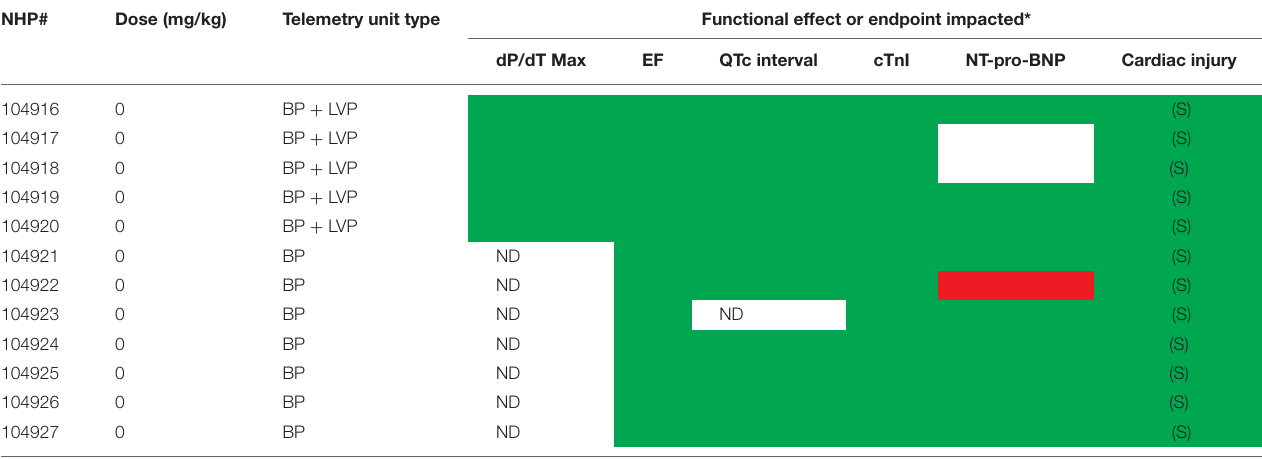
TABLE 4B | Relationship between contractile function, cardiac biomarkers, QTc interval and myocyte injury in NHP treated chronically with Vehicle. NHP# Dose (mg/kg) Telemetry unit type Functional effect or endpoint impacted* dP/dT Max EF QTc interval cTnI NT-pro-BNP Cardiac injury